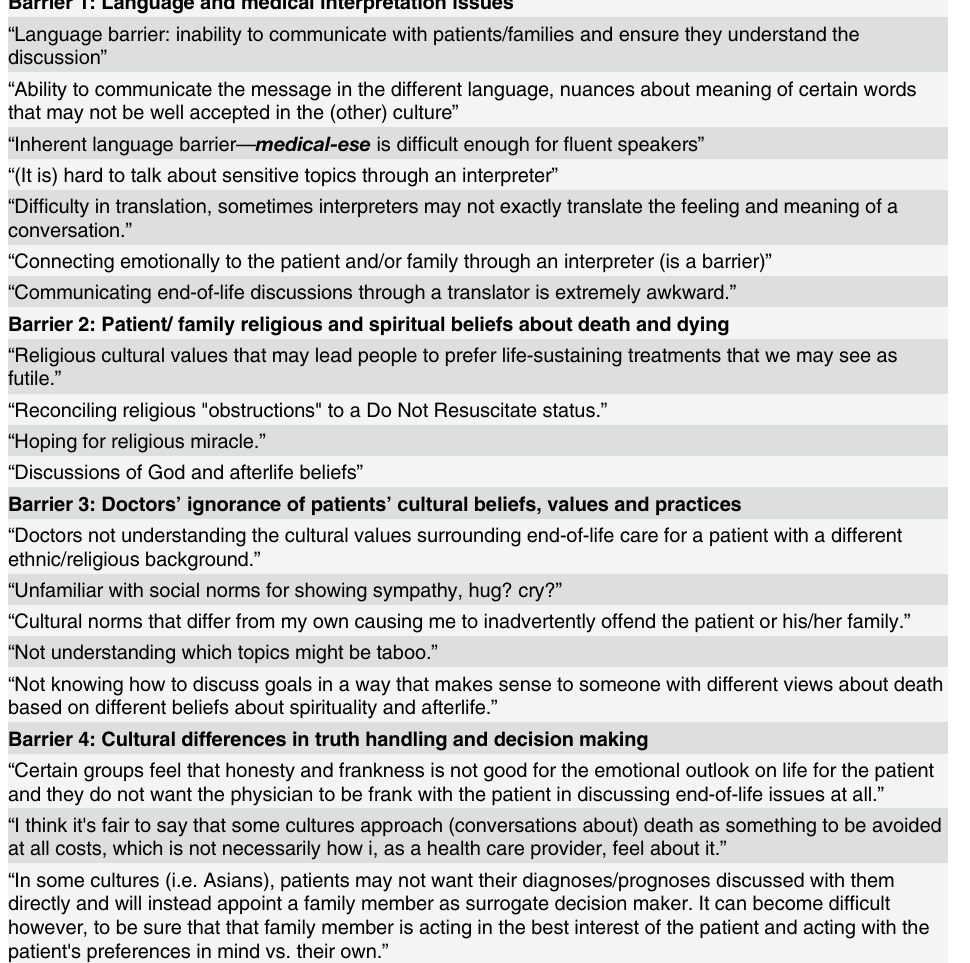
Table 1. Top six barriers (with exemplars) to effective end-of-life conversations with ethnic minorities according to multi-ethnic, multi-specialty doctors. Barrier 1: Language and medical interpretation